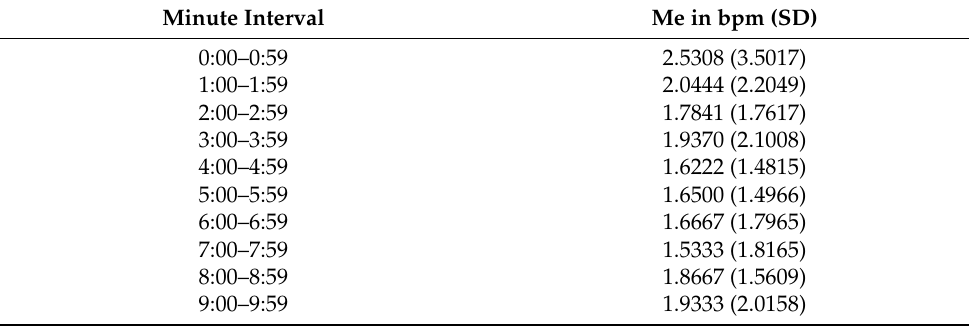
Table 2. Metric computation for heart rate minute by minute.